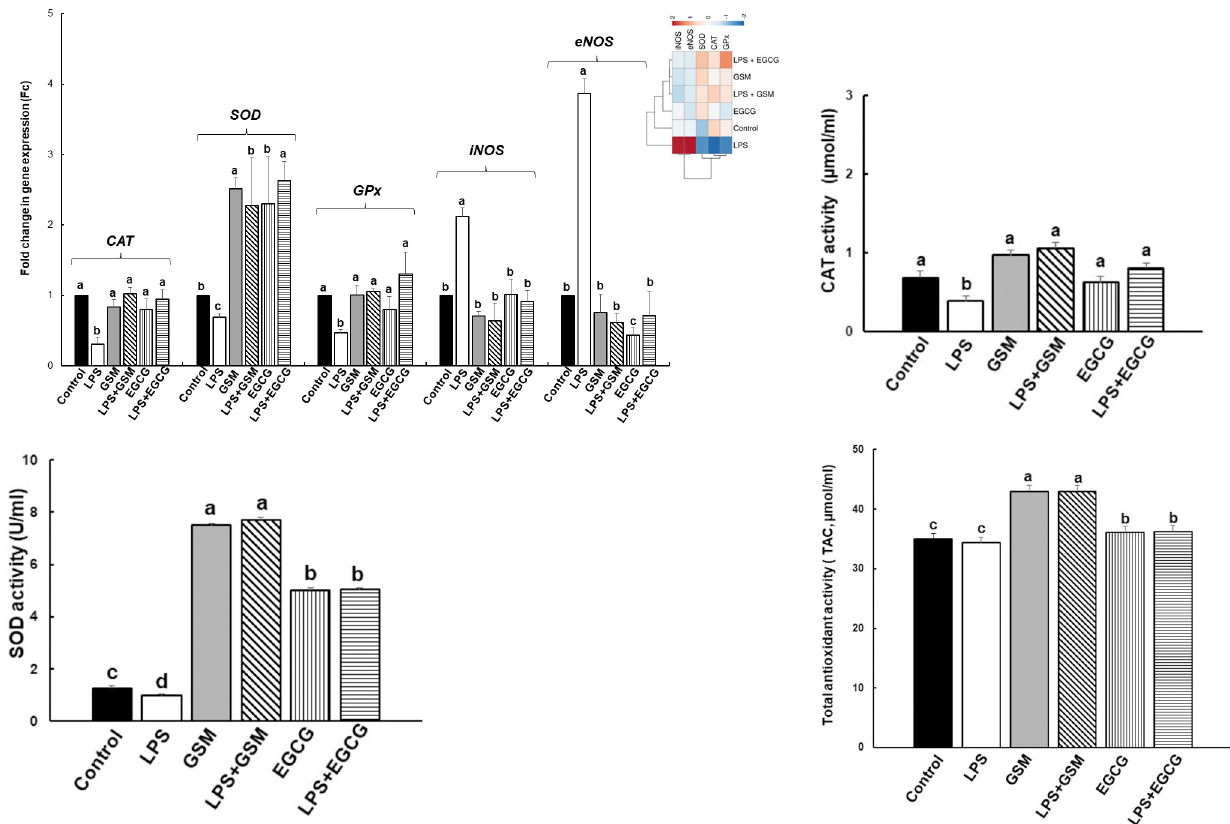
Fig 2. The effects of GSM on the antioxidant genes expression (A) and antioxidant activity (B, C, D) in IPEC-1 cells. IPEC-1 cells were incubated with the following treatments: Control = untreated cells; LPS = cells treated with LPS (5 μ g/ml) + 100 μ L culture media, 24h; GSM = cells pre-incubated 4h without LPS and treated after with 100 μ L (50 μ g/mL) of GSM phenolic extract; LPS + GSM = cells pre-incubated with LPS (5 μ g/ml) 4 h and treated after with 100 μ L (50 μ g/mL) of GSM phenolic extract 24h; EGCG = cells pre-incubated 4h without LPS and treated after with 100 μ L (23 μ g/ml) EGCG; LPS + EGCG = cells pre-incubated with LPS (5 μ g/ml) 4 h and treated after with 100 μ L (23 μ g/ml) EGCG, 24h. Results are presented as means ± standard errors, from three experimental series. a, b, c = Histograms for each group with unlike superscript letters were significantly different ( p < 0.050). The enzyme activities were expressed as: μ mol/ml (CAT), U/ml (SOD), μ mol/ml (TAC). The heatmap (the upper right panel) represents antioxidant gene expression levels in experimental groups of cells. The magnitude of gene expression level is represented by a colour scale (top) going from low (blue) to high